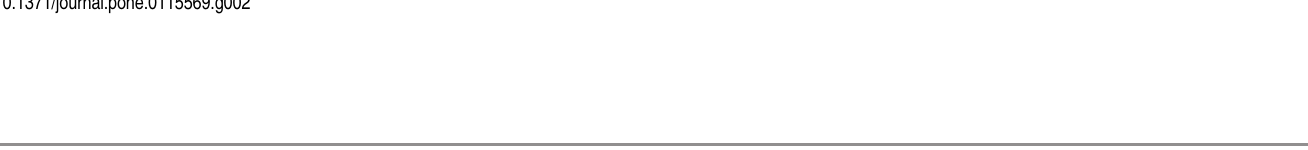
PLOS ONE | DOI:10.1371/journal.pone.0115569 December 31,